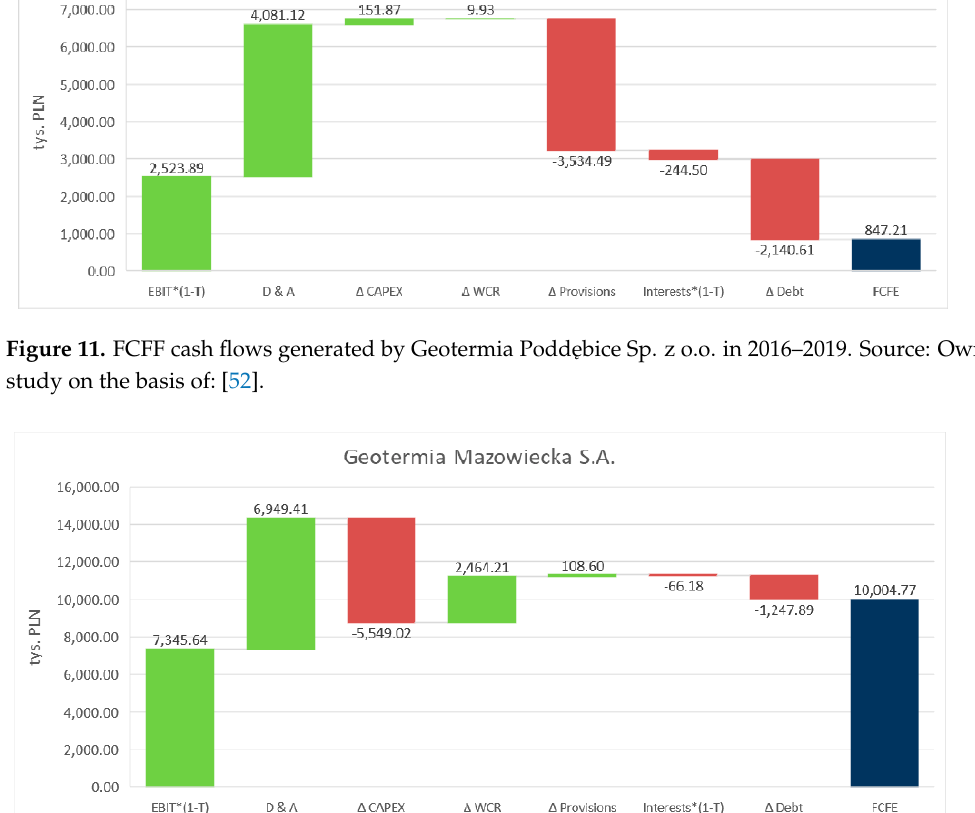
Figure 13. FCFF cash flows generated by Geotermia Pyrzyce Sp. z o.o. in 2016–2019. Source: Own study on the basis of: [54]. Figure 14. FCFF cash flows generated by Geotermia Czarnków Sp. z o.o. in 2016–2019. Source: Own study on the basis of: [55]. 6. Conclusions In Poland, energy production from geothermal sources is marginal and in recent years has not exceeded one percent. It should be stressed, however, that its systematic development can be seen, but it is determined by financial outlays for the identification of deposits and the study of their geothermal properties in the light of limiting future invest- ment risks. Investment opportunities and further development of the geothermal energy sector therefore depend on the possibility of financing its development through cash generated